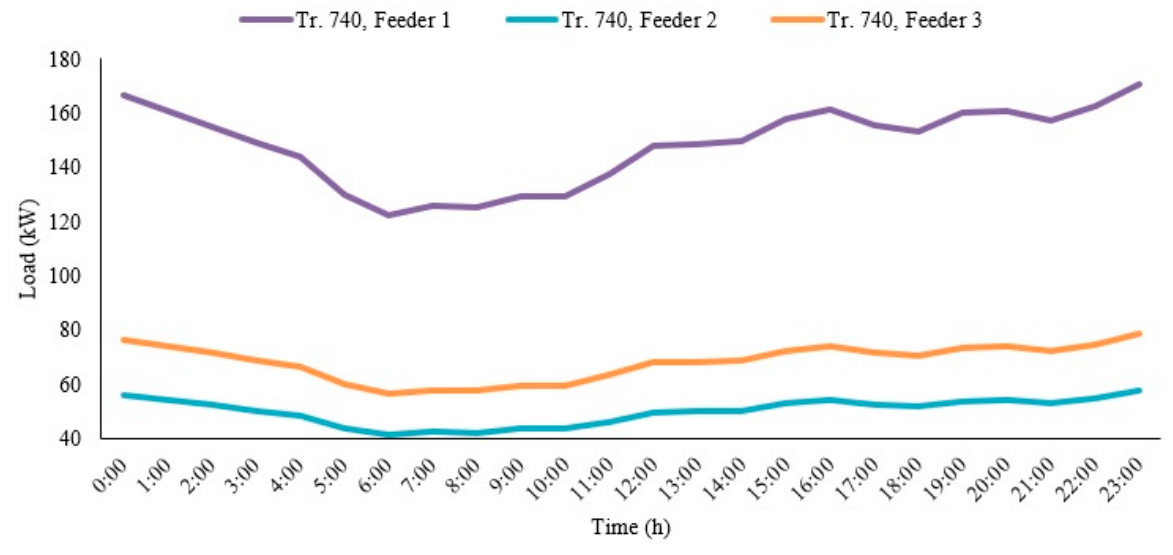
Figure 11. Load profiles of Transformer 740 in summer with 0% EVC. The voltage profiles for all feeders of Transformer 740 with 0% EVC are shown in Figure 12. The peak voltage occurs at 6:00 am due to minimum load as shown in load profile figures. The voltage in Figure 12, the voltage of Tr. 740, Feeder 2 is above the rated voltage (415 V) because it was measured practically at Feeder 2 with maximum voltage drop ( − 1.2%) according to Table 6 so the over voltage is 4.98 V above the rated voltage. The standard limit for voltage drop is approximately 7%.